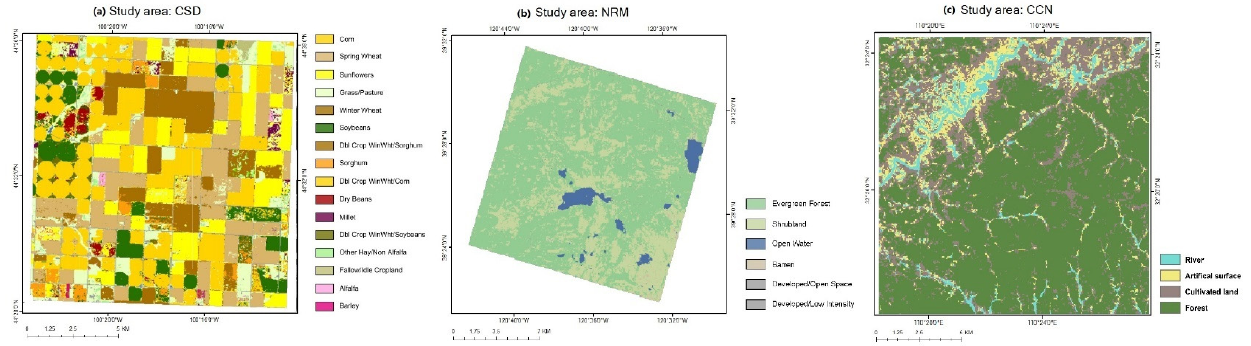
Figure 2. Land cover types for the three study areas. (a) Central South Dakota (CSD); (b) northeast of Rocky Mountains (NRM); (c) central China (CCN).